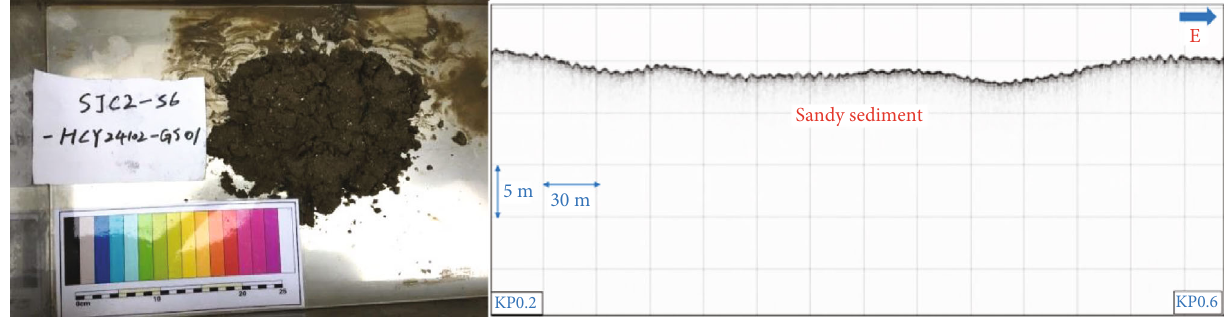
Figure 9: Typical sediment photos and shallow stratigraphic section images of the landing section (left is the sediment photo, and right is the shallow stratigraphic section image).